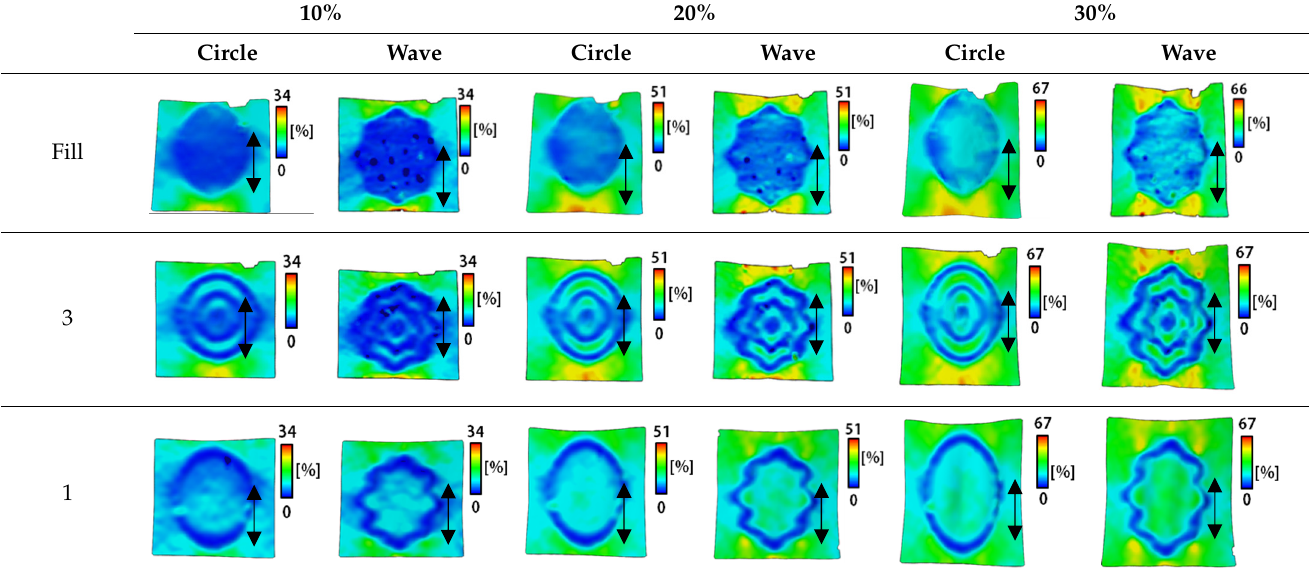
Table 3. DIC images of the single-type embroidery-based textile electrode by tensile change.